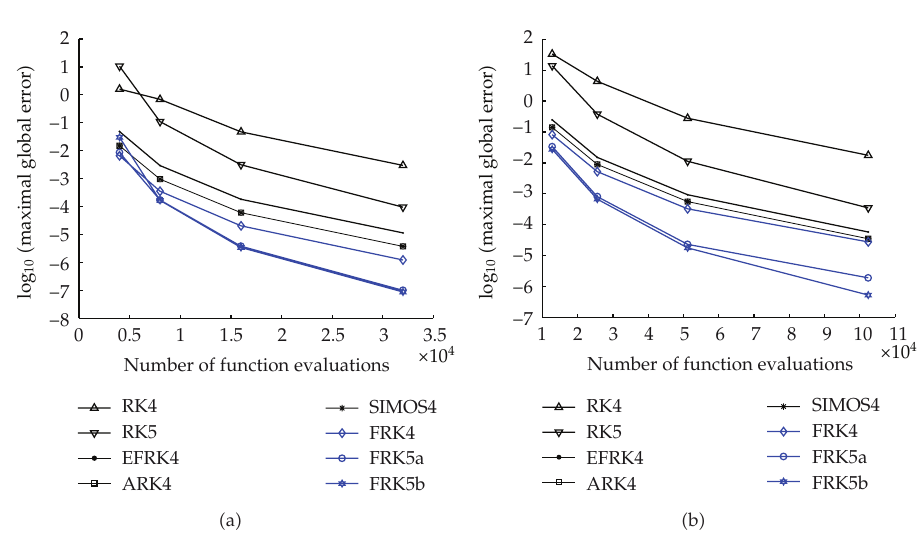
Figure 3: E ffi ciency curves of Problem 1 (cid:3) a (cid:4) and Problem 2 (cid:3) b (cid:4)